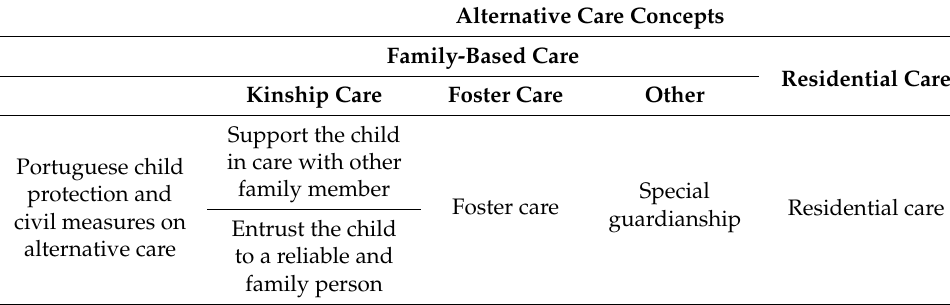
Table 1. A proposal categorisation of alternative care concepts. Source: own elaboration.